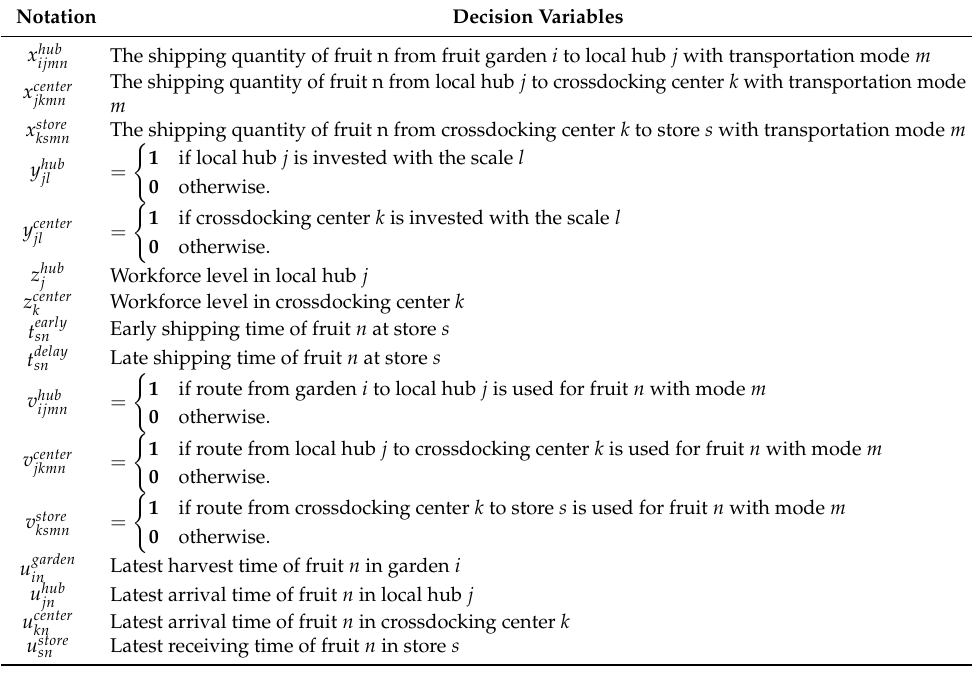
Table 3. Model decision